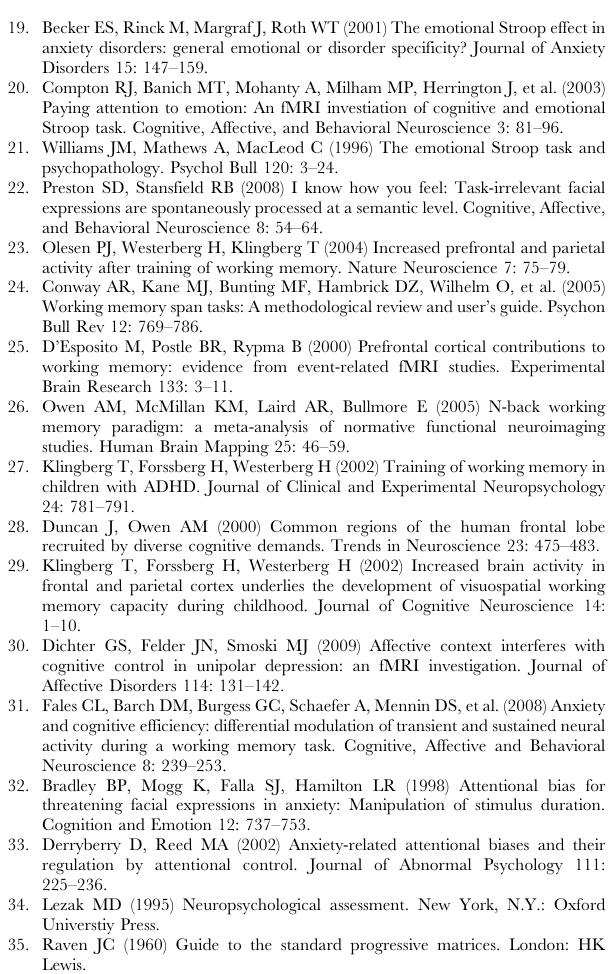
Table S2 Mean pre- and post-training reaction times on the Emotional Stroop across the three training